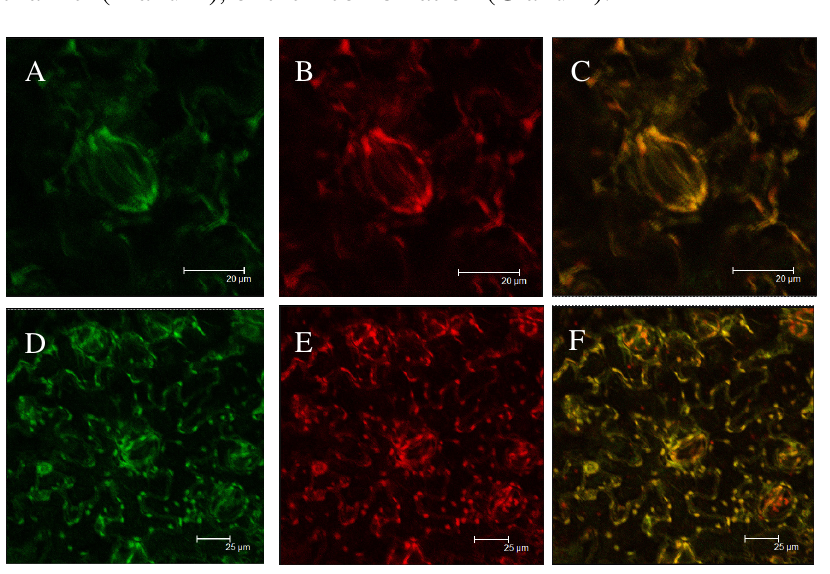
proteins. Microscopic images of GFP ( A and D ), chloroplast autofluorescence ( B and E ), and merge ( C and F ) from tobacco epidermal cells infected with Agrobacteria harboring the GFP constructs. GFP fused to TaHO1 transit peptide ( A – C , scale bar = 20 µ m) and GFP alone (negative control, D – F , scale bar = 25 µ m). The photographs were taken in the blue channel ( A and D ), red channel ( B and E ), or their combination ( C and F